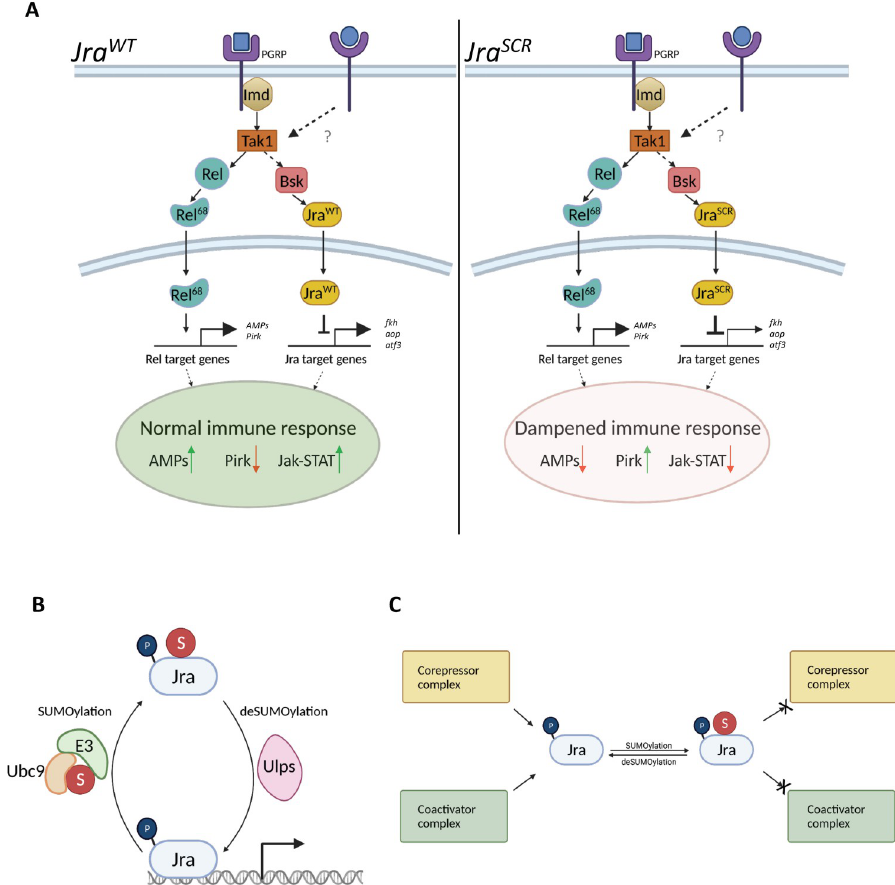
Fig 7. SUMOylation of Jra regulates the gut immune response. A. Peptidoglycan recognizing receptors on the cellular surface recognize pathogens and activate the Imd signalling cascade. Both Rel and Jra are transcriptional effectors for this pathway and they act to evoke a robust immune response. Our data places Jra as an important effector and modulator of the immune GRN (left panel). In a scenario where Jra is resistant to SUMO conjugation (right panel), we find that the immune response is dampened, favouring the proliferation of the pathogen. B. A small fraction of SUMOylated Jra can influence the robustness of the host defense response in the gut. We propose that the SUMO conjugation/deconjugation of Jra is a dynamic process, regulated by the nuclear SUMO conjugation machinery, and occurring on the promoters Jra target genes. Dynamic cycles of SUMOylation fine-tunes the activity of Jra with SUMOylated Jra maintained at low levels, i . e . << 5% of total Jra. C. The mechanism for effect of SUMO conjugation on Jra mediated transcription in Drosophila is not clear. Multiple possibilities exist; SUMOylation may influence activation and/or repression by Jra, and this activity may depend on context, with SUMOylated Jra interacting differentially with the transcriptional machinery at Jra target promoters. Images for this figure have been generated using BioRender